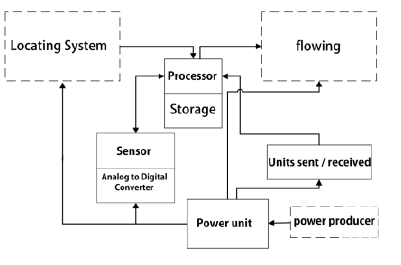
Figure. 2 Main components of a sensor